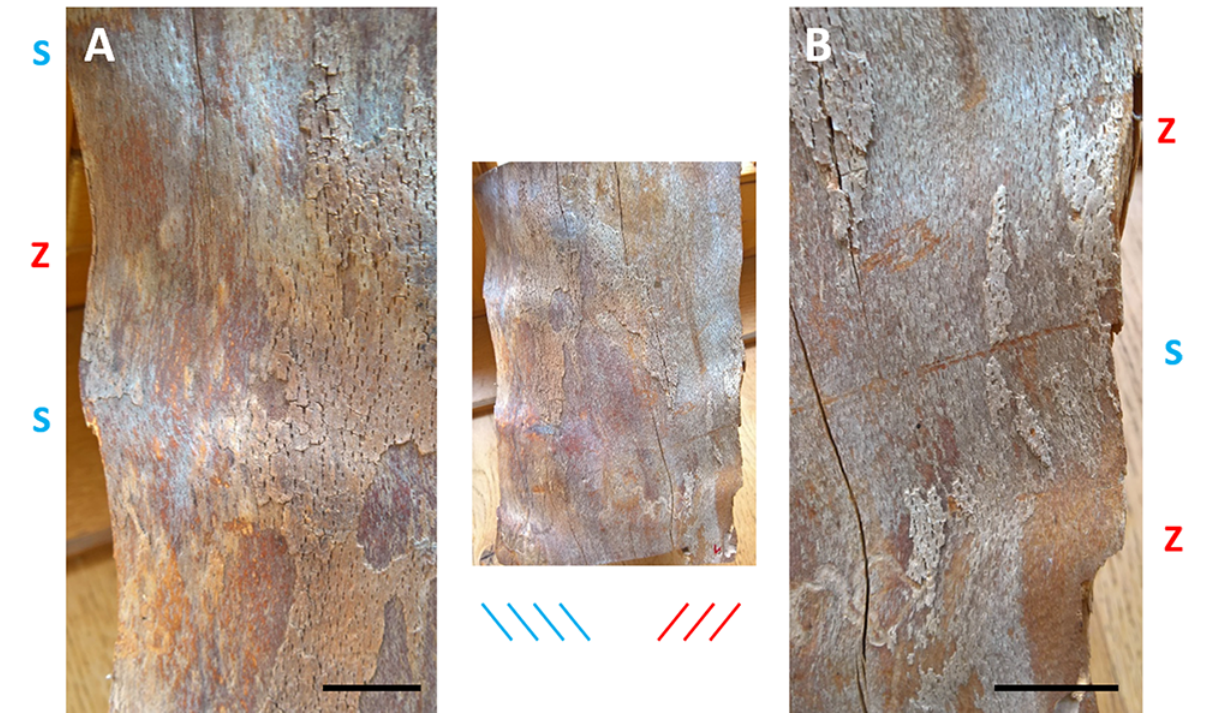
Figure 7 Outermost tangential face of the beechwood sample with two separate ripple patterns (middle photo); the ripples are S-oriented in the le pattern ( A ) and Z-oriented in the right one ( B ); both patterns differ in the sequence of opposite grain deviations atop of their crests; it is S/Z for the le pattern and Z/S for the right one. Scale bars: 25